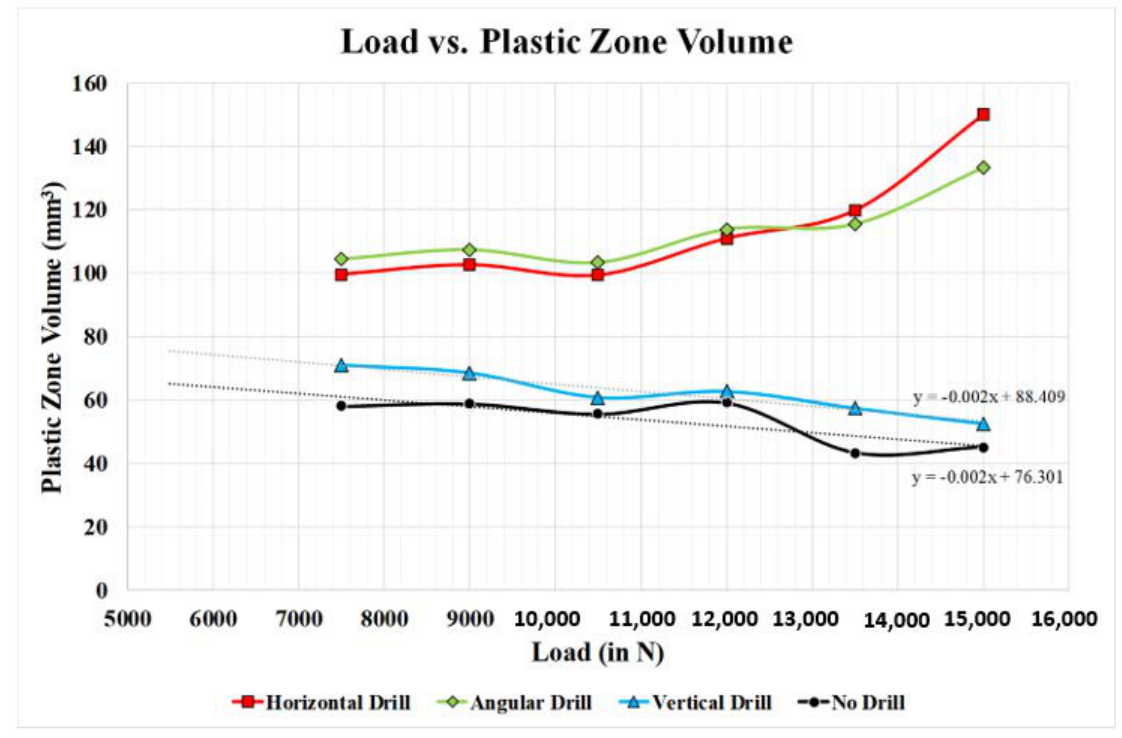
Figure 6. Development of plastic zone volume with increasing load for di ff erent drill hole